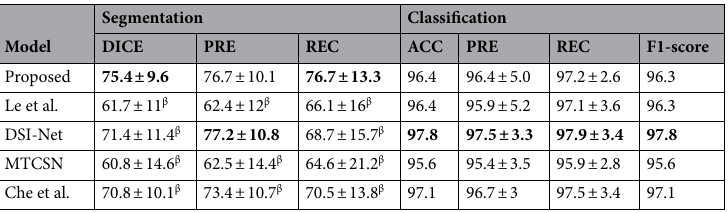
Table 5. Comparison of the VENet performance against other multitask DCNN for CVD classification and segmentation (mean ± S.D.). β p < 0.05, Paired t test against the proposed VENet strategy. α p < 0.05, Two-sided McNemar’s test against the proposed VENet strategy. Bold values indicate best